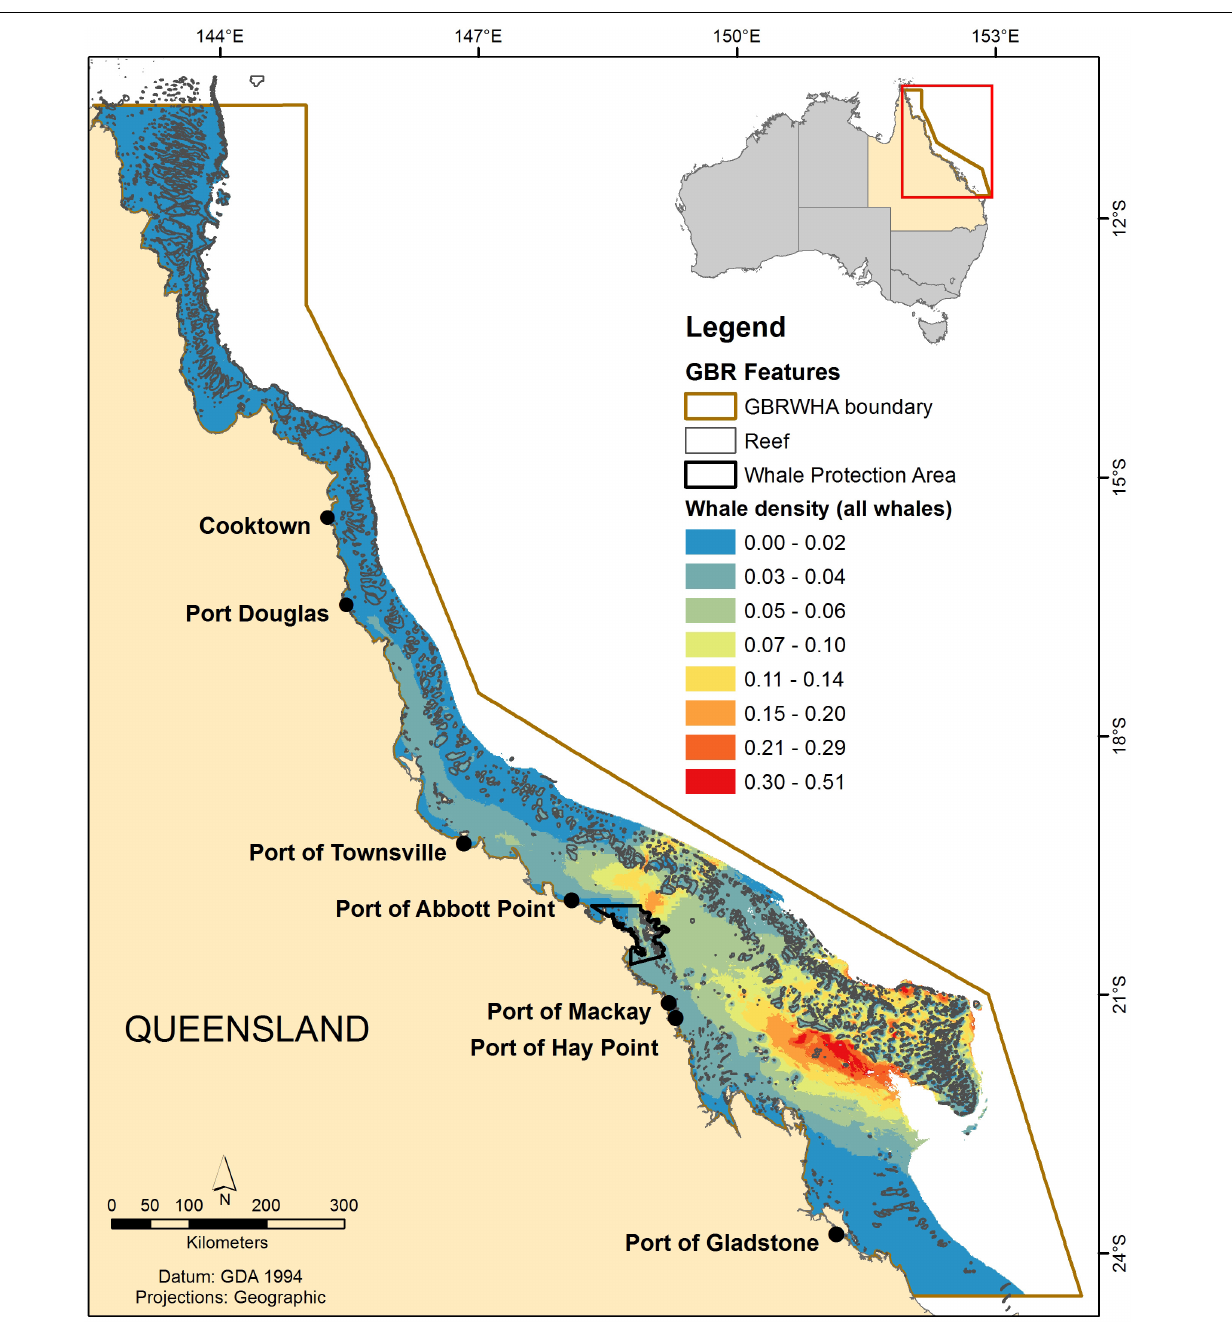
and Traffic Separation Schemes (TSS) (Silber et al.,